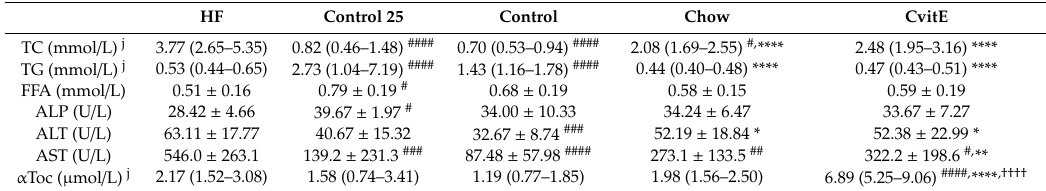
Table 3. Plasma values.